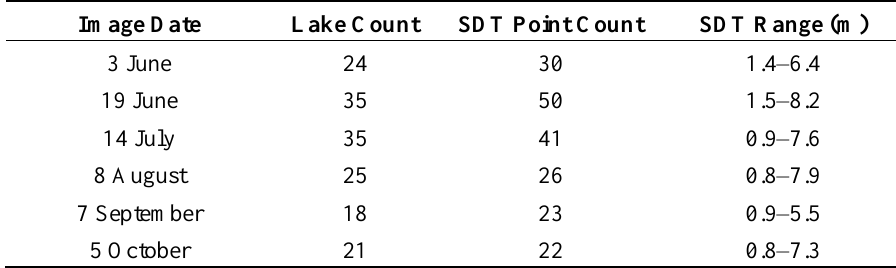
Table 2. The number of Secchi disk transparency (SDT) points, the SDT point depth range, and the number of lakes used to calibrate the regressions for each MODIS image